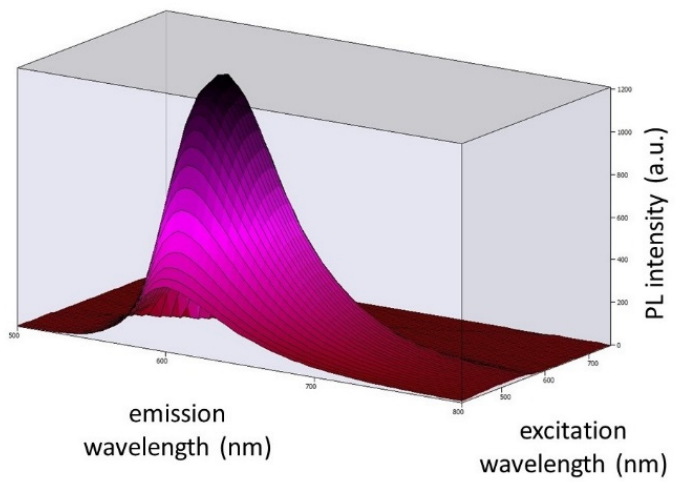
Figure 9. Three-dimensional photoluminescence spectra of Nile Red dye embedded in EVA polymer at excitation wavelengths ranging from 410 nm to 740 nm and emission wavelengths ranging from 500 nm to 800 nm.